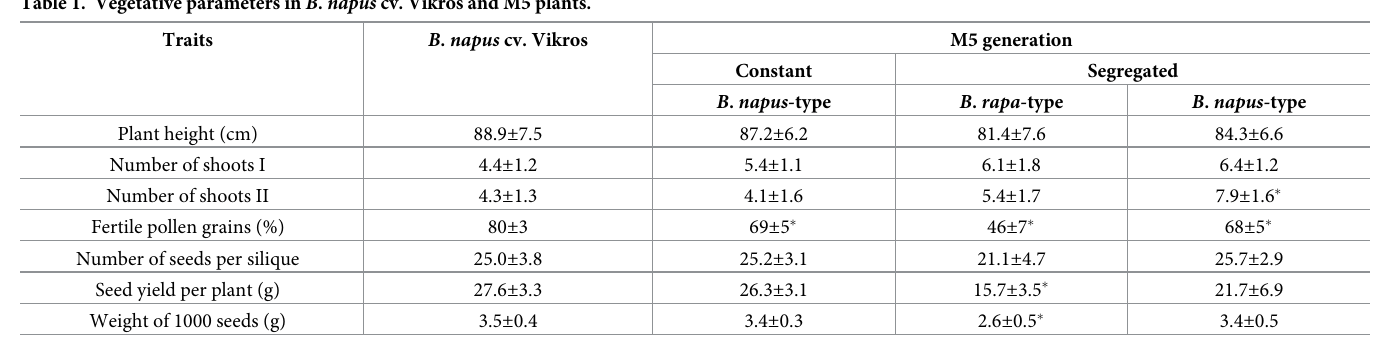
Each meaning represents the mean value ± standard deviation � The values are significantly different at P �